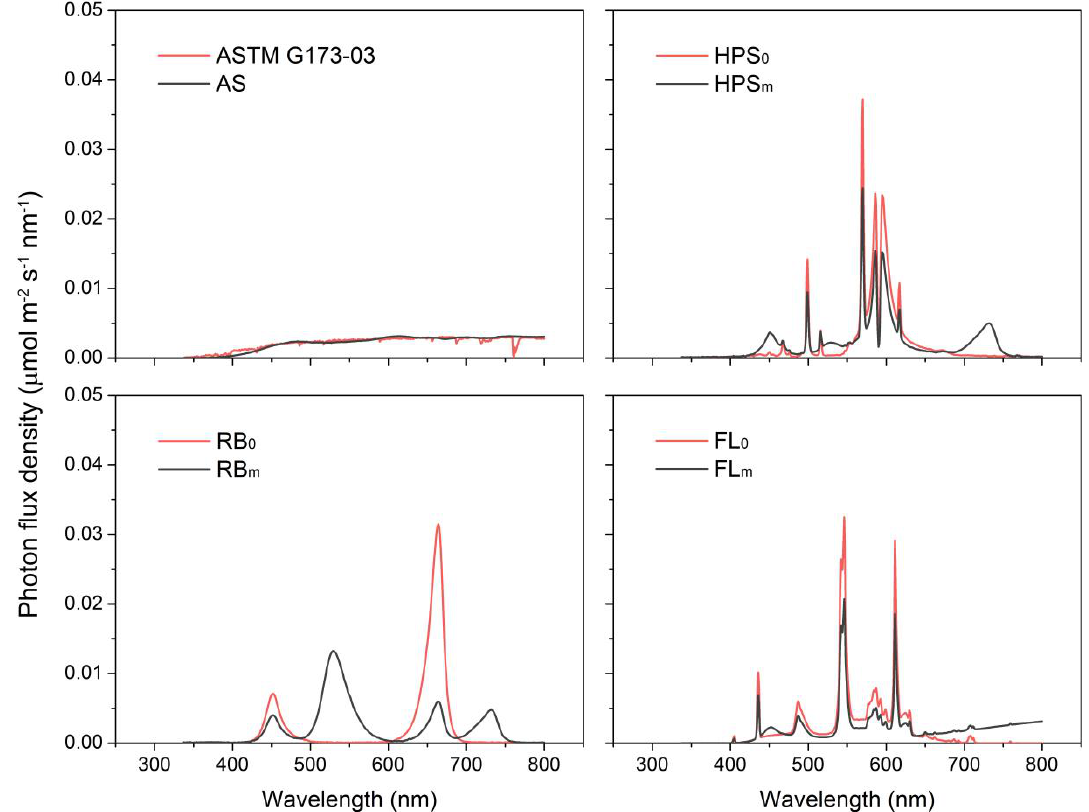
Figure 2. Emission spectra of light sources for each treatment condition. See 2.5 for specifics about the modified light sources.